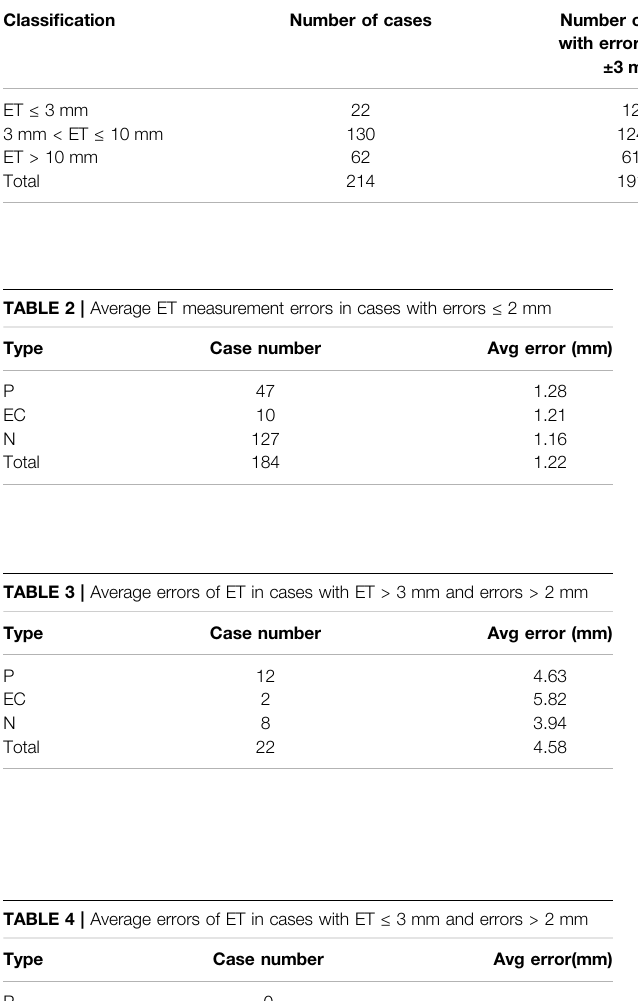
TABLE 1 | Measurement results